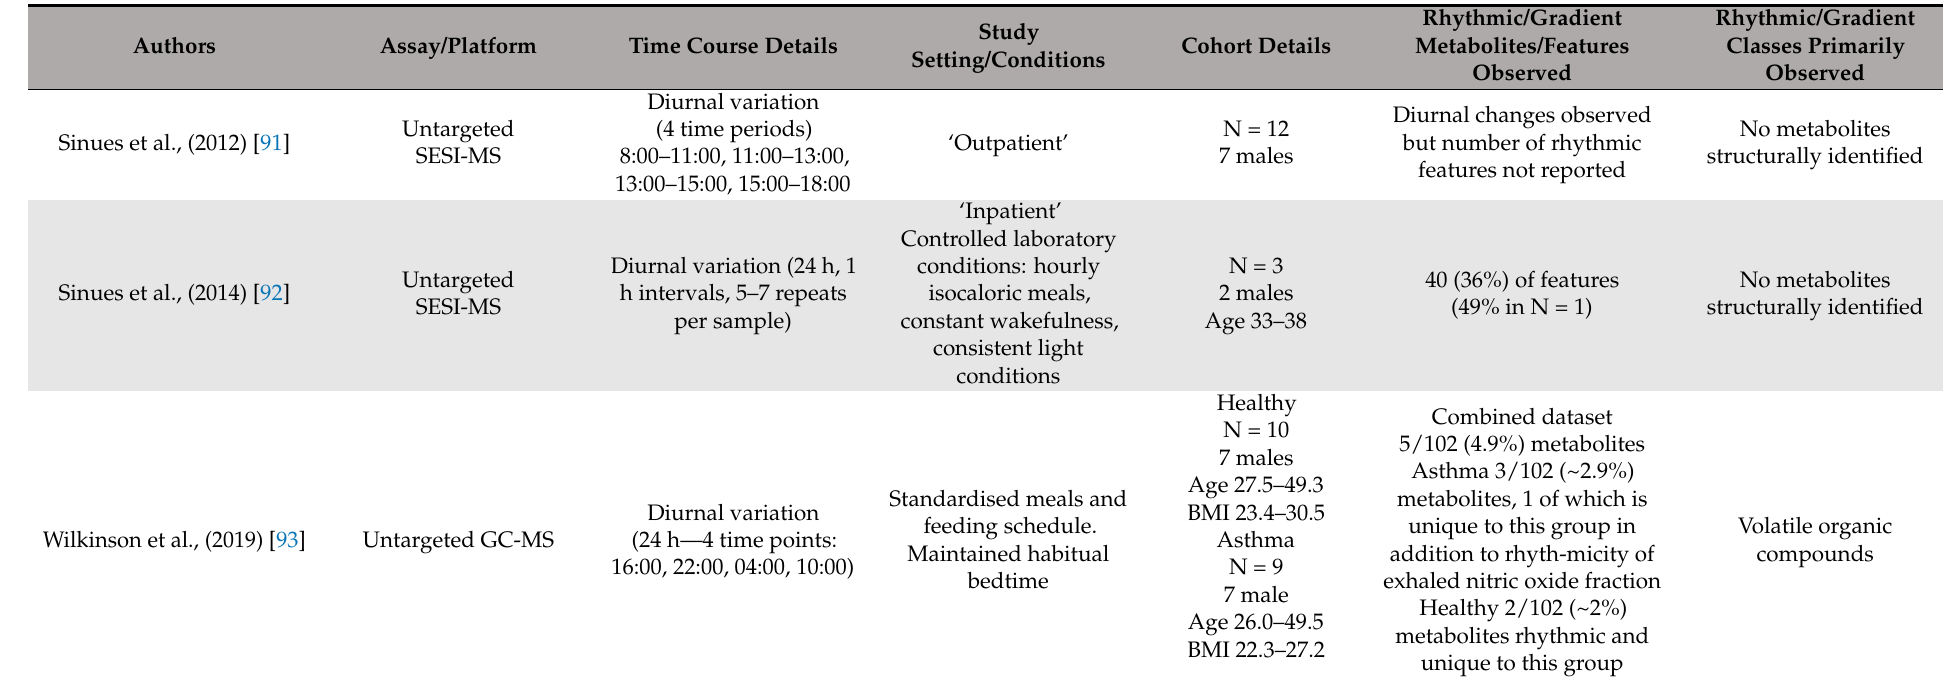
Table 5. A brief summary of study design, cohort details and results with regard to observed time of day variation of metabolites for relevant studies analysing